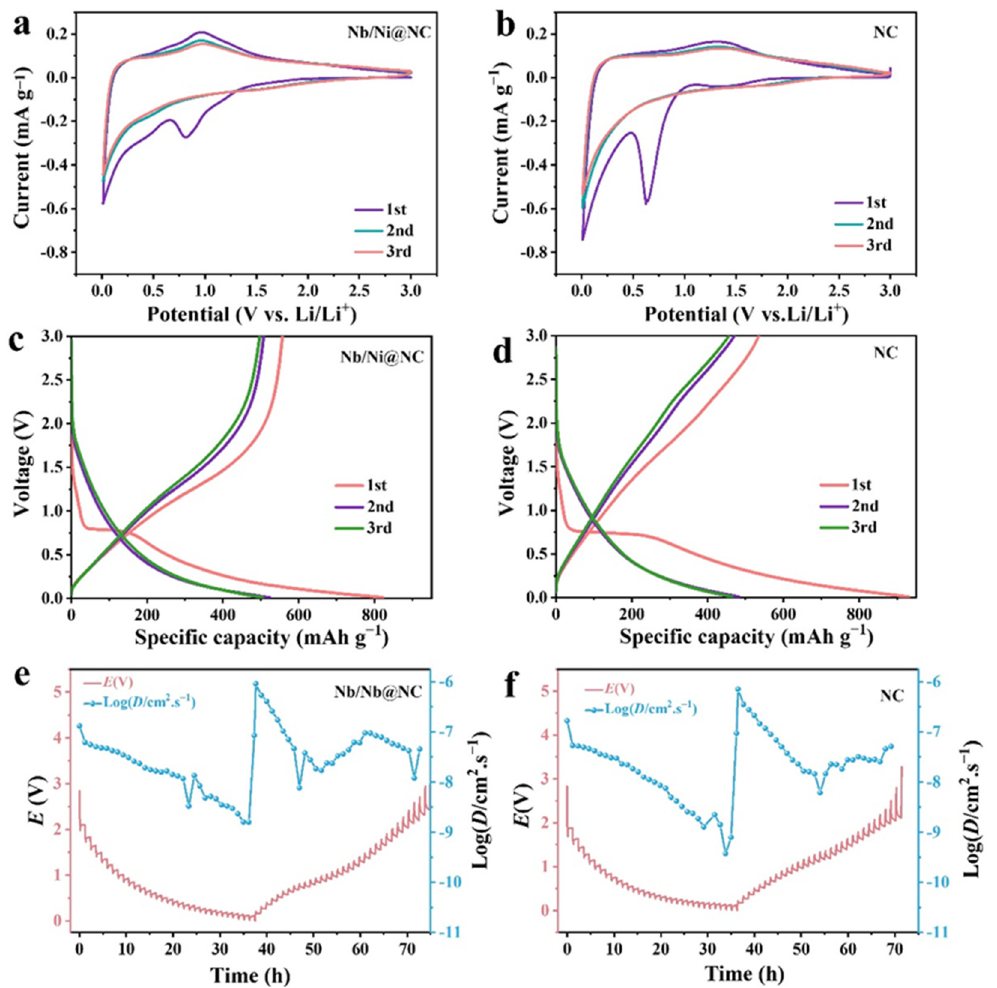
Figure 5. ( a , b ) Initial three CV curves of flexible Nb/Ni@NC and NC electrodes at 0.1 mV s − 1 ; ( c , d ) initial three charge/discharge curves of flexible Nb/Ni@NC and NC electrodes at 0.2 mA g − 1 ; ( e , f ) GITT curves and the corresponding Li + diffusion coefficient of the flexible Nb/Ni@NC and NC electrode materials.